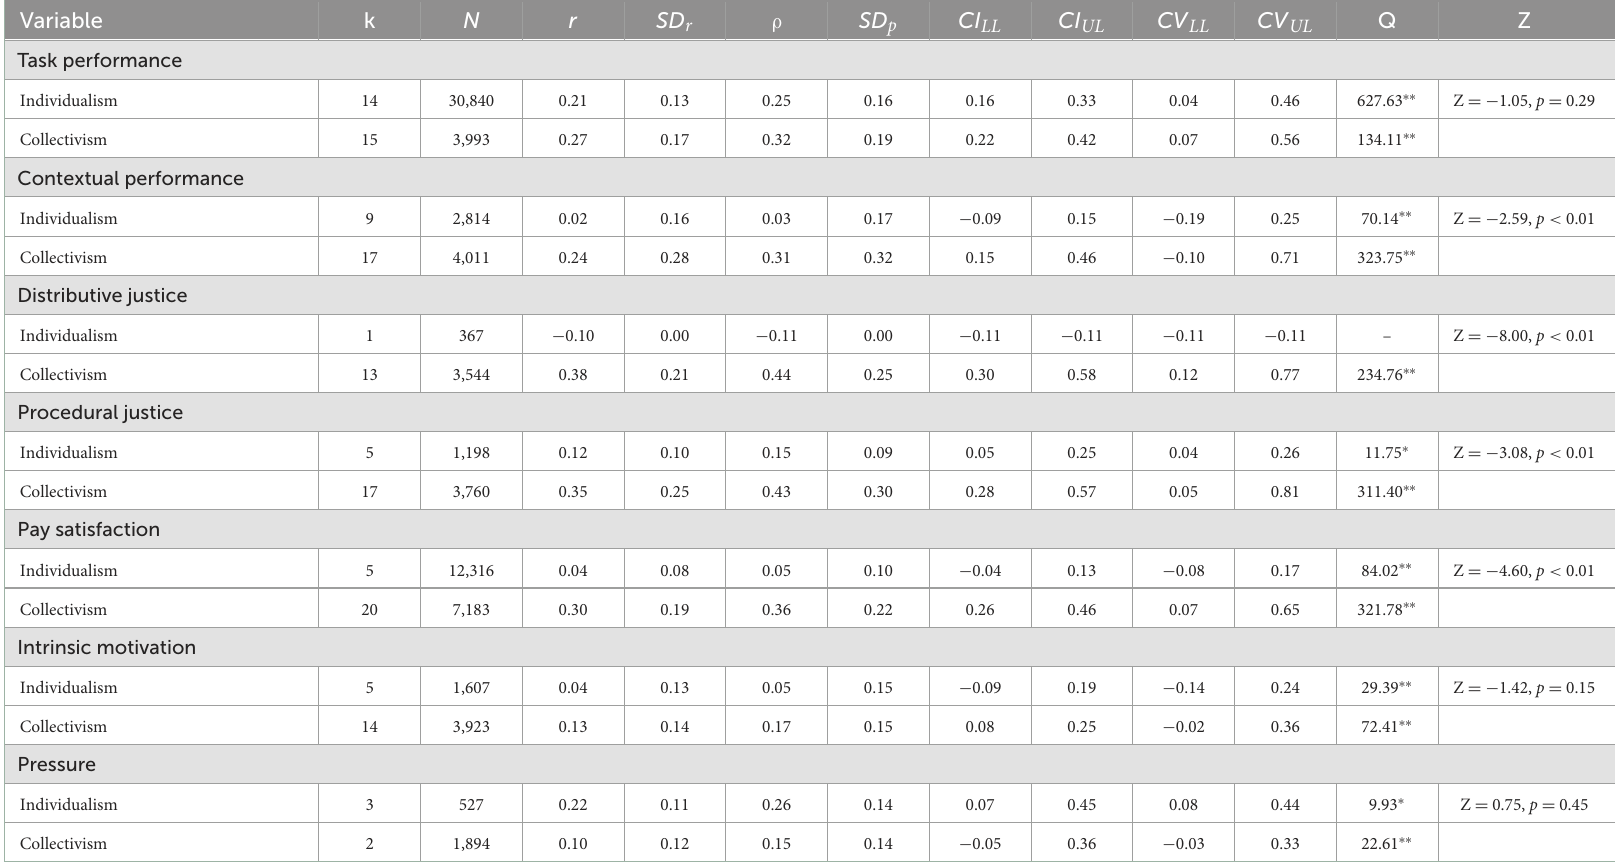
TABLE 7 Moderating effect of national culture on relationships between PFP and